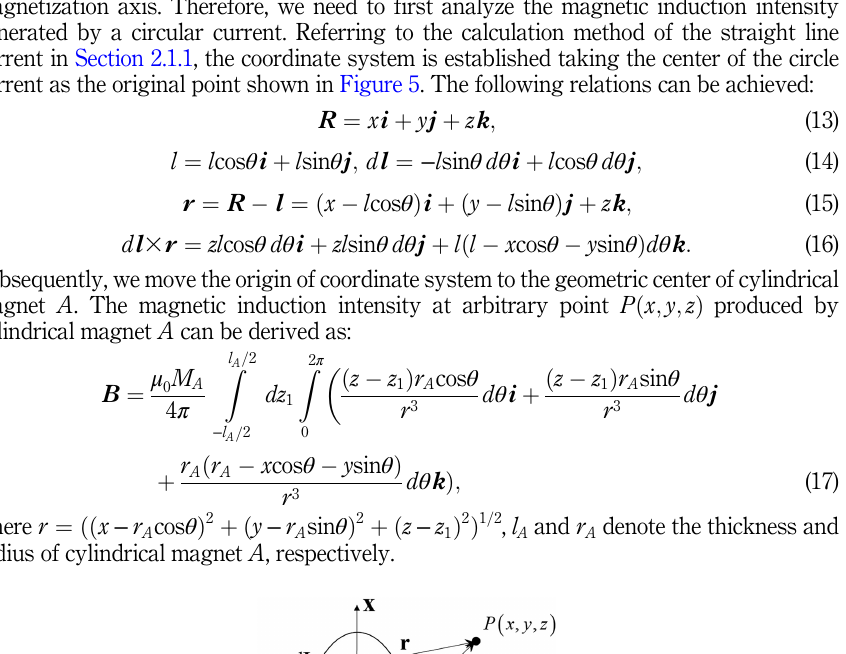
Figure 4. The positions of magnetizing currents on the surfaces of interacting magnets in the coordinate